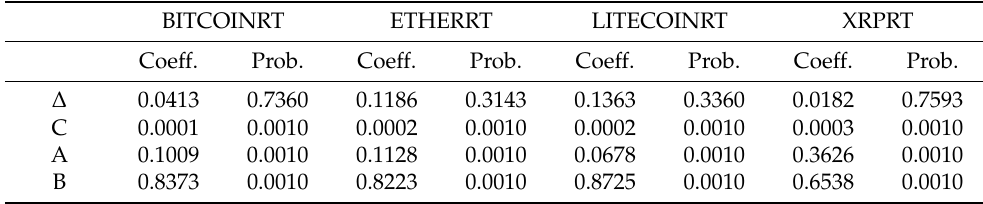
Table 11. GARCH-M